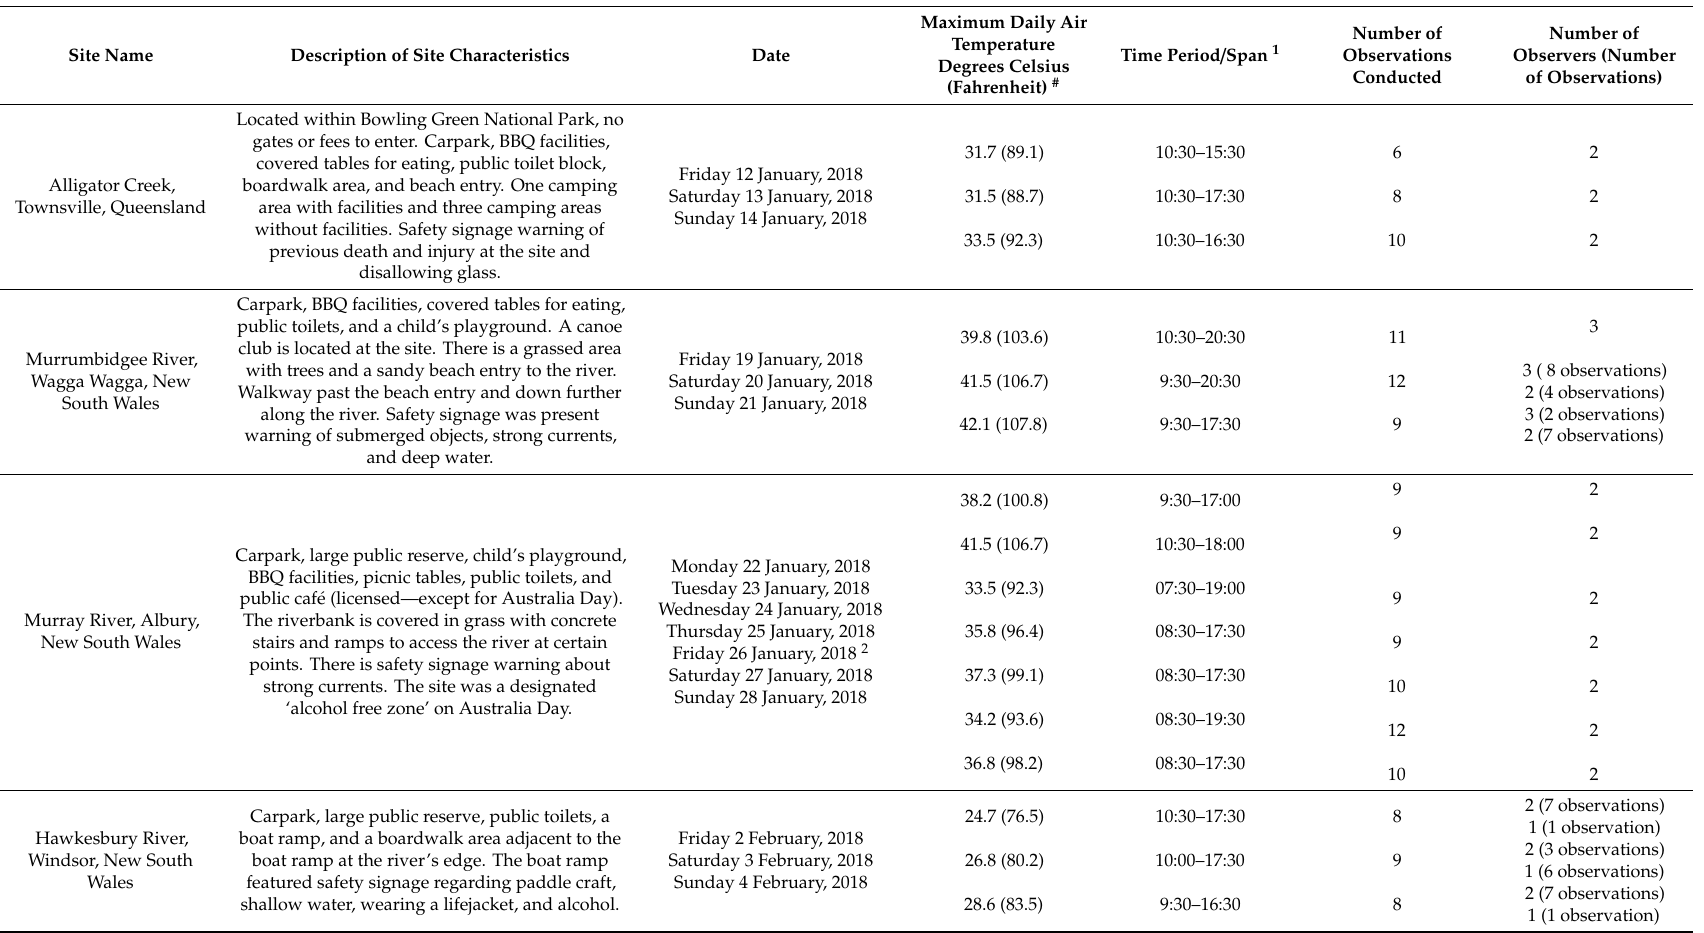
Table 1. Data collection sites by time period, timeframe of observations, maximum daily air temperature, number of observations conducted and number of